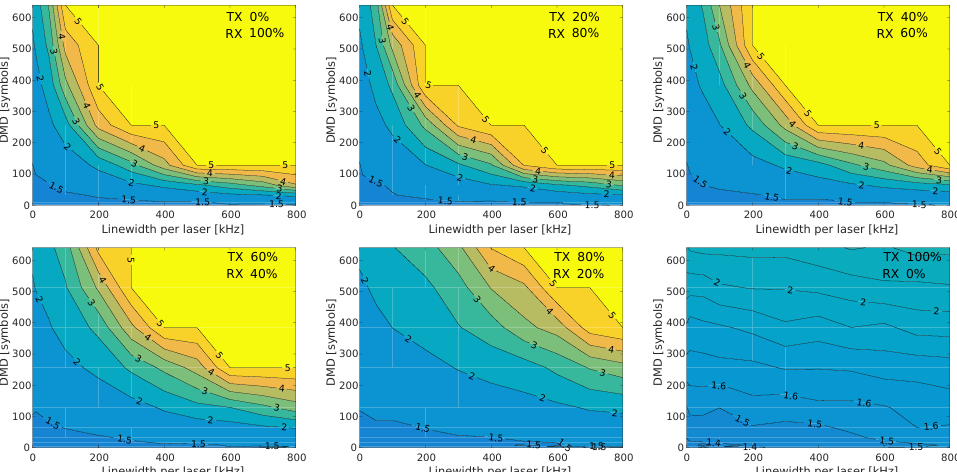
Figure 10. OSNR penalties in dB, computed at a BER of 10 − 4 , for 16-QAM modulation and model B for several distributions of the phase noise between the transmitter and receiver